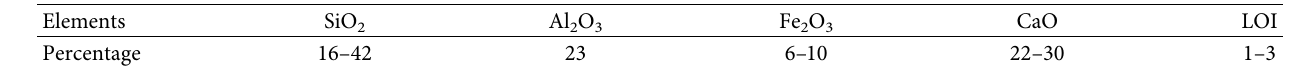
Table 2: Flyash composition (% wt).